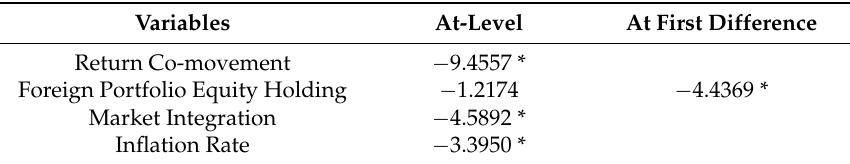
Table 2. ADF statistics and Mackinnon (1996) one-sided p